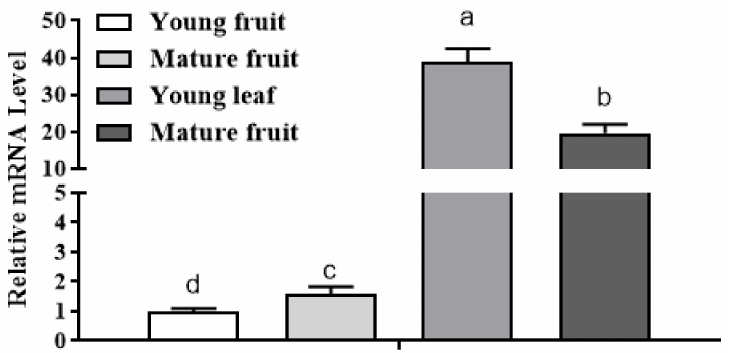
Figure 3. Analysis of PpGAD2 expression in the different tissues of ‘Akibae’. Young leaves (third to fourth leaf from the top of leaf), mature leaves (second to third leaf from the bottom of shoot), young fruit (60 DAF) and mature fruit (105 DAF). The lower case letter on the bars represent standard errors from three independent replicates.